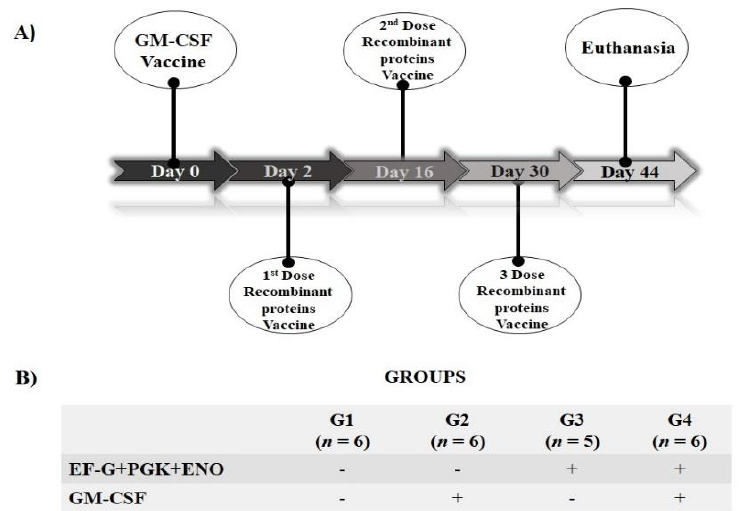
Figure 1. Scheme of the timeline of immunization ( A ) and experimental groups ( B ). EF-G: elongation factor g recombinant S. aureus protein; PGK: transmembrane protein phosphoglycerate kinase recombinant S. aureus protein; ENO: enolase recombinant S. aureus protein; GM-CSF: pCI-granulocyte and macrophage colony-stimulating factor plasmid DNA. The unvaccinated group was merely administrated saponin adjuvant to liposome.